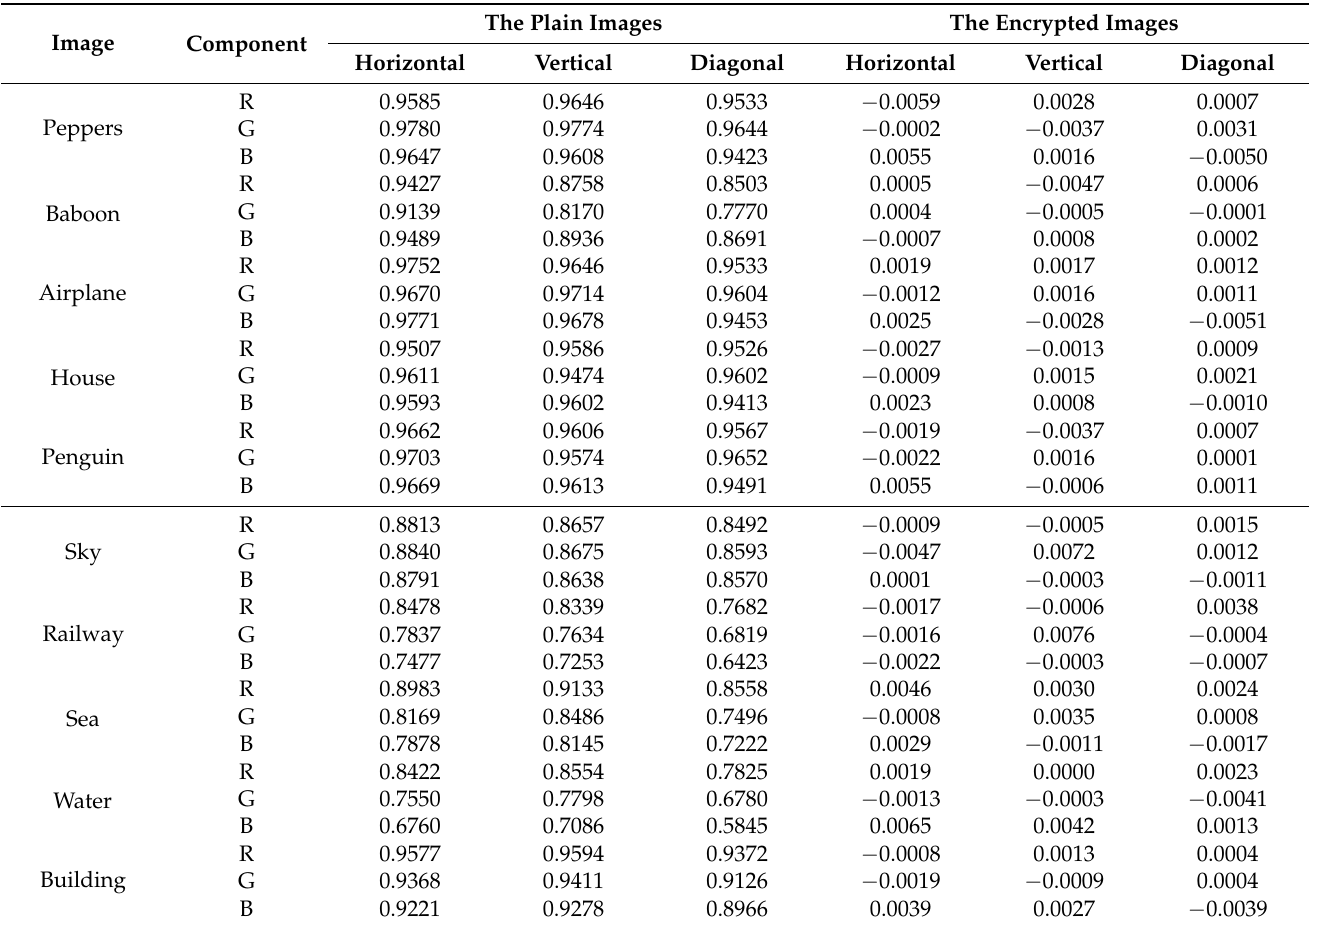
Table 10. Correlation coefficient values of adjacent pixels in three different